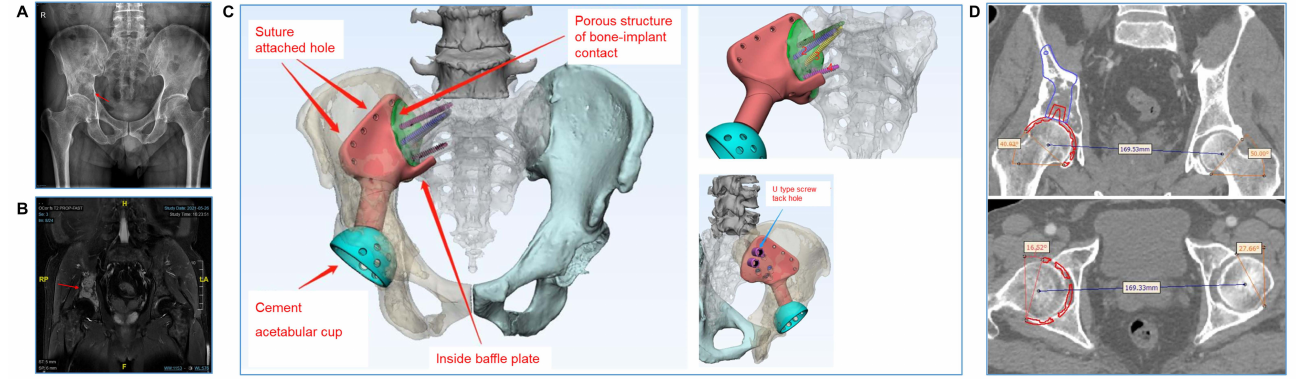
Figure 1. Case 2. Prosthesis design and installation simulation. ( A , B ) Preoperative X-ray and MR displayed the tumor involving the right acetabulum and ilium (red arrow). We planned to totally remove the right iliac bone from the right sacroiliac joint position. ( C ) Design of the 3D-printed hemipelvic endoprosthesis. The prosthesis is modular, and consists of an iliac holder (red) and an acetabular cup (blue). Between the iliac holder prosthesis and the autologous bone surface, a porous structure with a size of 2.5 mm mimicking the trabecular bone was designed (green) to promote bone ingrowth and fusion. In the sacroiliac joint, the design included four screws (icons 1, 2, 3 and 4), bypassing the sacral canal and knocked into the anterior side of the sacrum. Of these, screws 1, 2, and 3 are knocked into S1, while screw 4 is knocked into S2. Two U-shaped screw track holes are included at the rear of the prosthesis with which to fix the nail rod system. ( D ) Simulated installation of the 3D-printed acetabular cup; the abduction angle is about 40 ◦ , and the anteversion angle is about 16 ◦